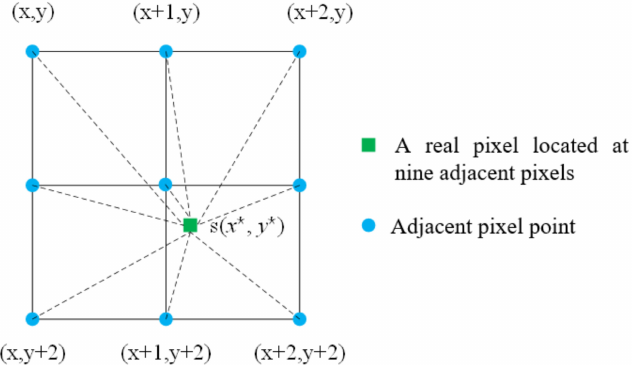
Figure 3. Schematic diagram of first-order nine-point